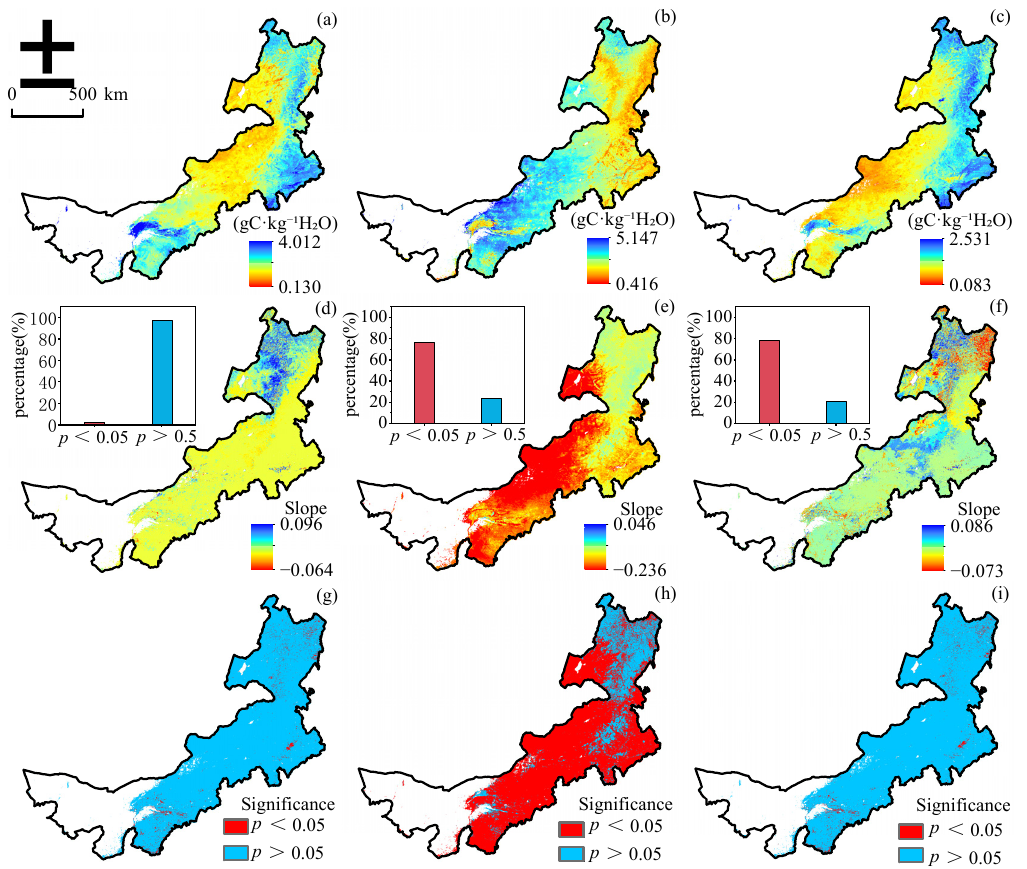
Figure 6. Characteristics of the distribution, as well as the general trend of change, of the yearly mean value of eWUE. ( a – c ) Average eWUE for spring, summer and autumn; ( d – f ) spring, summer and autumn eWUE trends; ( g – i ) spring, summer and autumn eWUE significance.